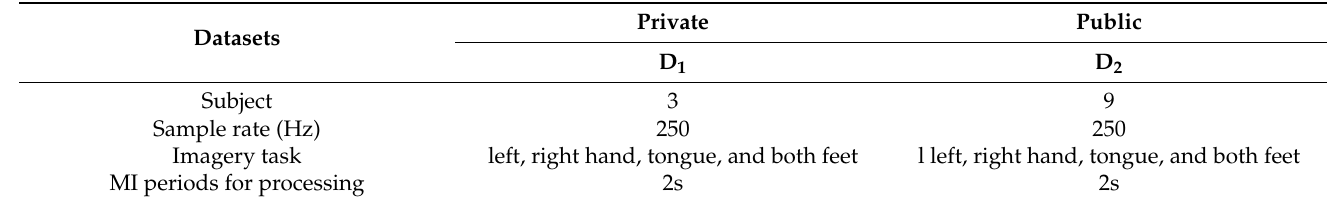
Table 1. Properties of raw